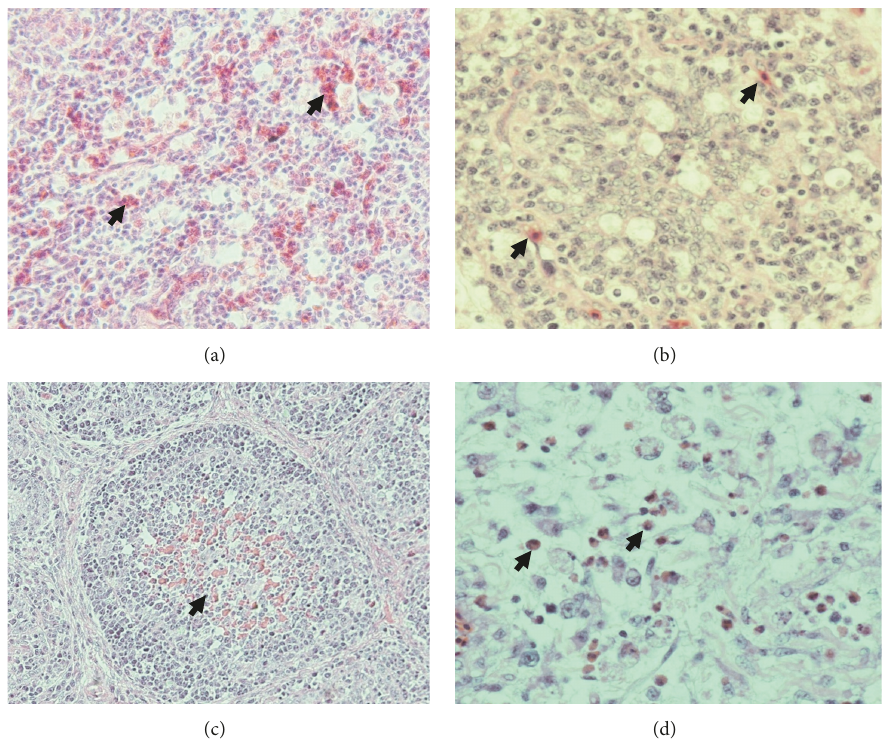
Figure 9: Effect of 5% SAP on the immune-expression of CD4+ and CD8+ lymphocytes in the spleen and BF of the broiler chicken fed a diet with naturally contaminated with AF on day 21. High immune-expression of CD4+ lymphocytes (arrow) (a); low immune-expression of CD8+ lymphocytes (b) in the white pulp of the chicken’s spleen in group V; high immune-expression of CD4+ lymphocytes (arrow) (a); low immune-expression of CD8+ lymphocytes (b) in the lymphoid follicle of the chicken’s BF in group V. IHC antibody anti-CD4+, DAB, 100 × (a), 1000 × (b); IHC antibody anti-CD8+, DAB, 100 × (c), 1000 ×